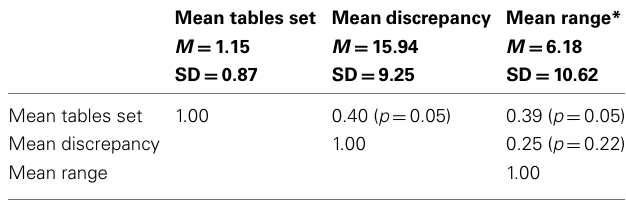
Table 2 |The correlations between table setting, discrepancy, and range